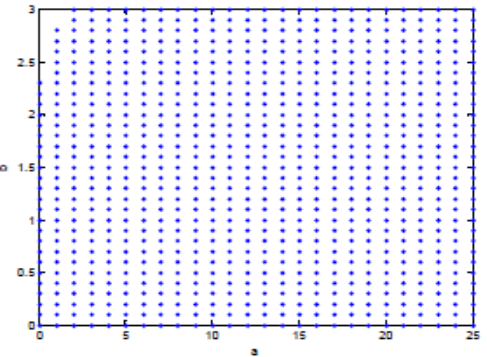
Figure 8. Stability regions for m = 100 and δ =